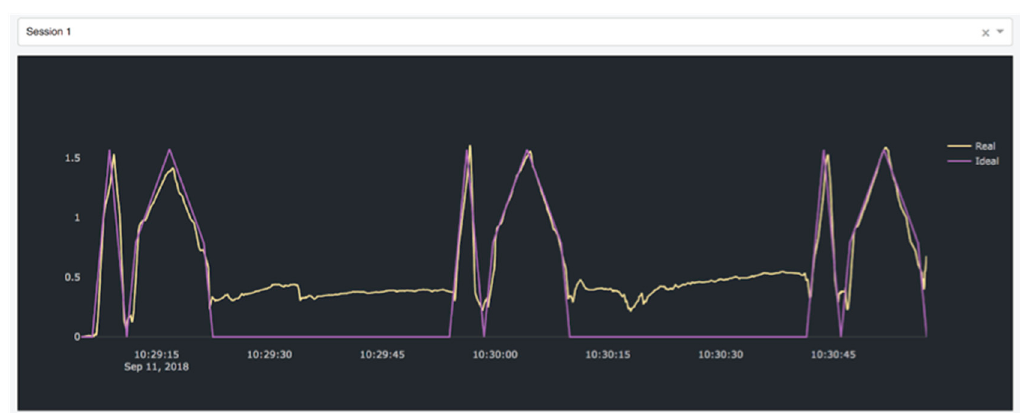
Figure 10. Professional interface, single-exercise detail.